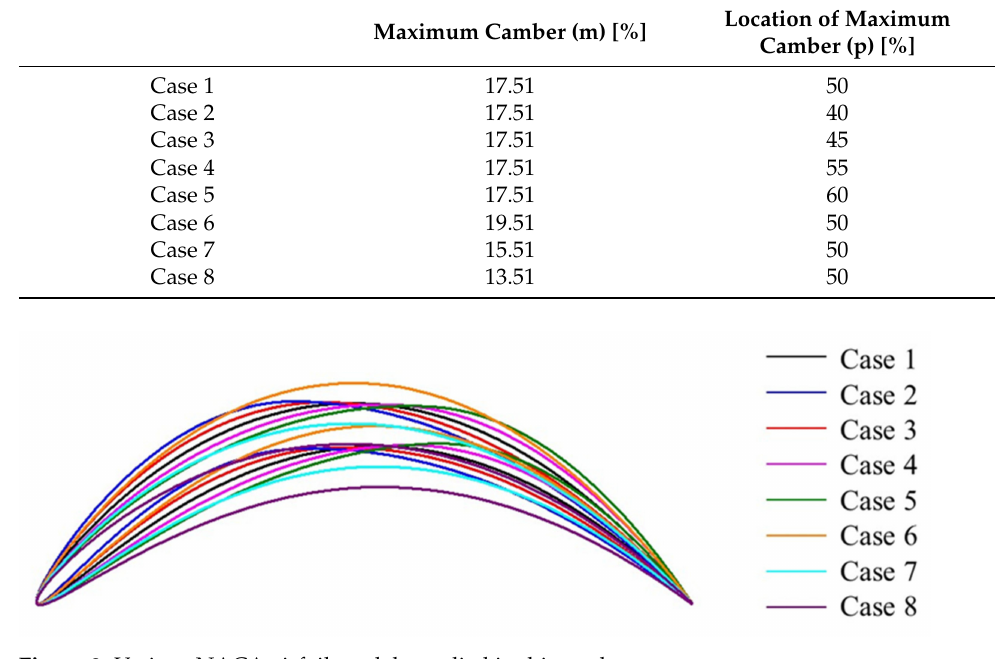
Figure 3. Various NACA airfoil models applied in this